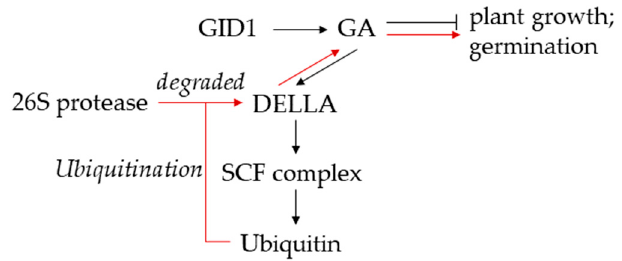
Figure 1. Negative feedback regulatory pathway of GA in plant germination and growth. Arrow “ → ” indicates induction or promotion, while bar “ ˧ ” indicates inhibition. Black arrows indicate the binding sequence of GID1, GA, DELLA and the SCF complex, and the promoting effect of GA on seed germination and plant growth is inhibited. The red arrows indicate that after the ubiquitinated DELLA protein is degraded by the 26S protease, GA is released and plays its role in promoting germination and plant growth.